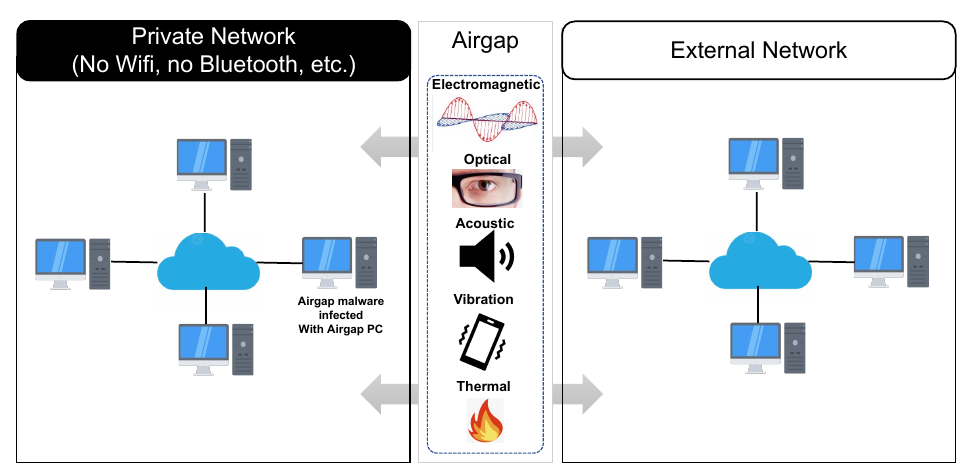
Figure 3. Air-gap attack